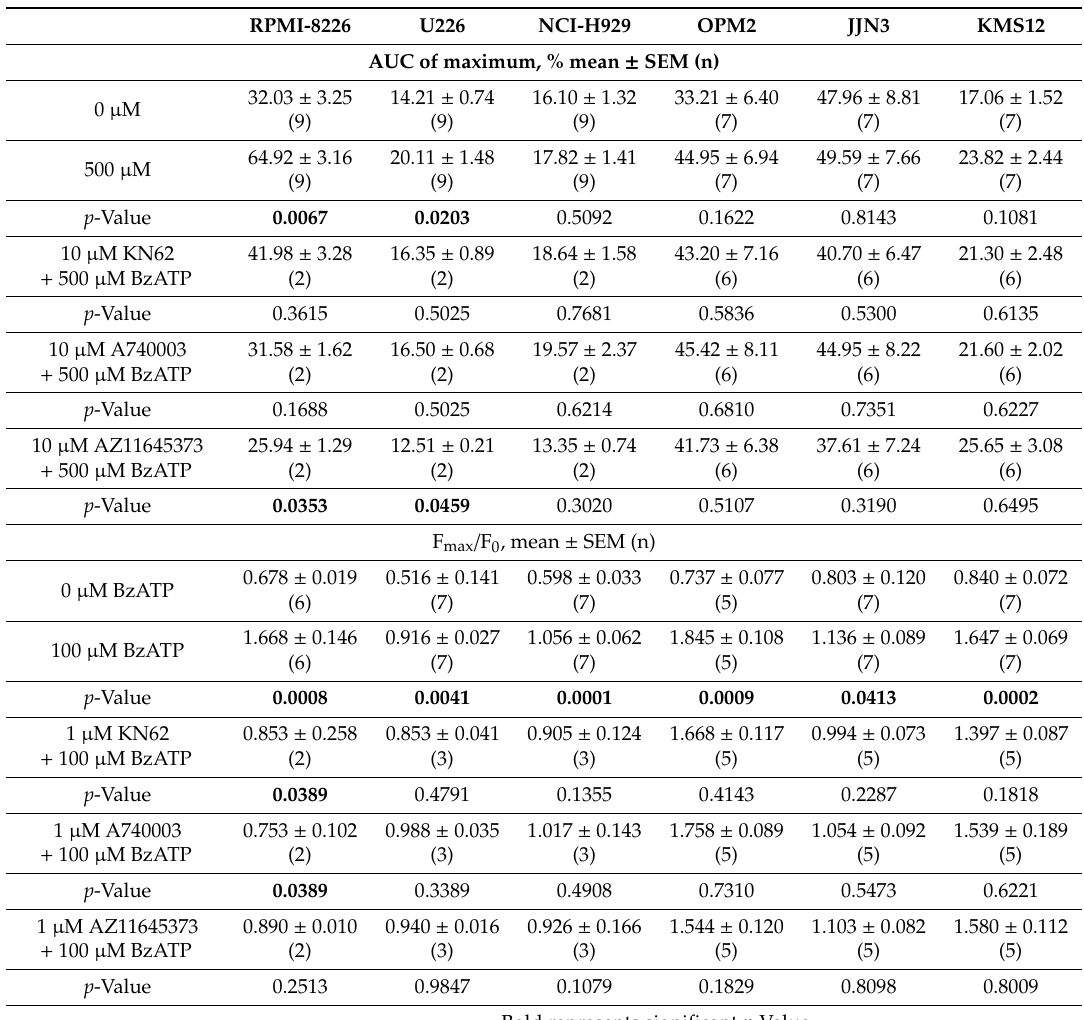
Table 1. Summary of P2X7 receptor pore formation and channel function induced by BzATP in all